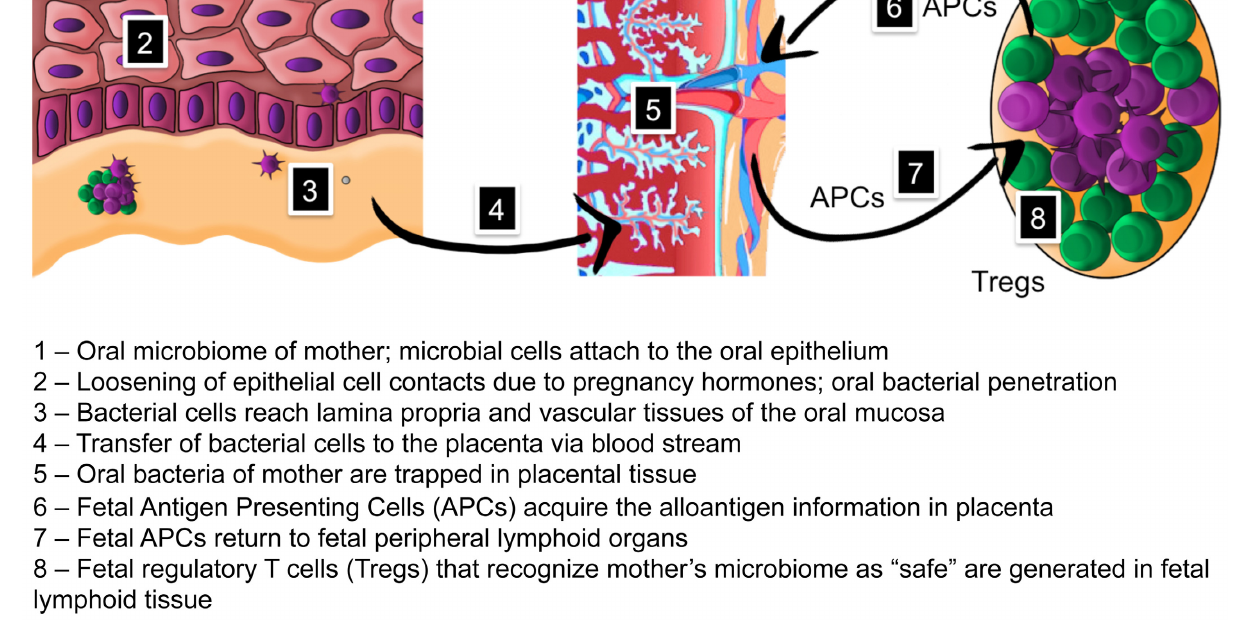
FIGURE 1 | Hypothesis on the role of placental microbiome in the development of fetal tolerance toward oral microbiome of